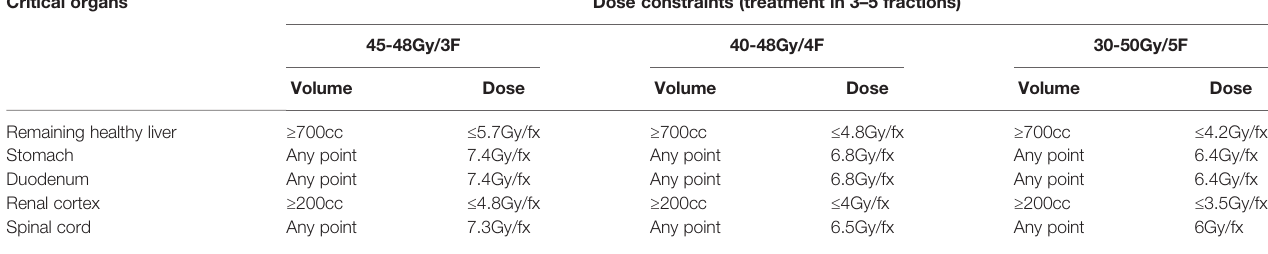
TABLE 2 | Dose constraints for critical organs. Critical organs